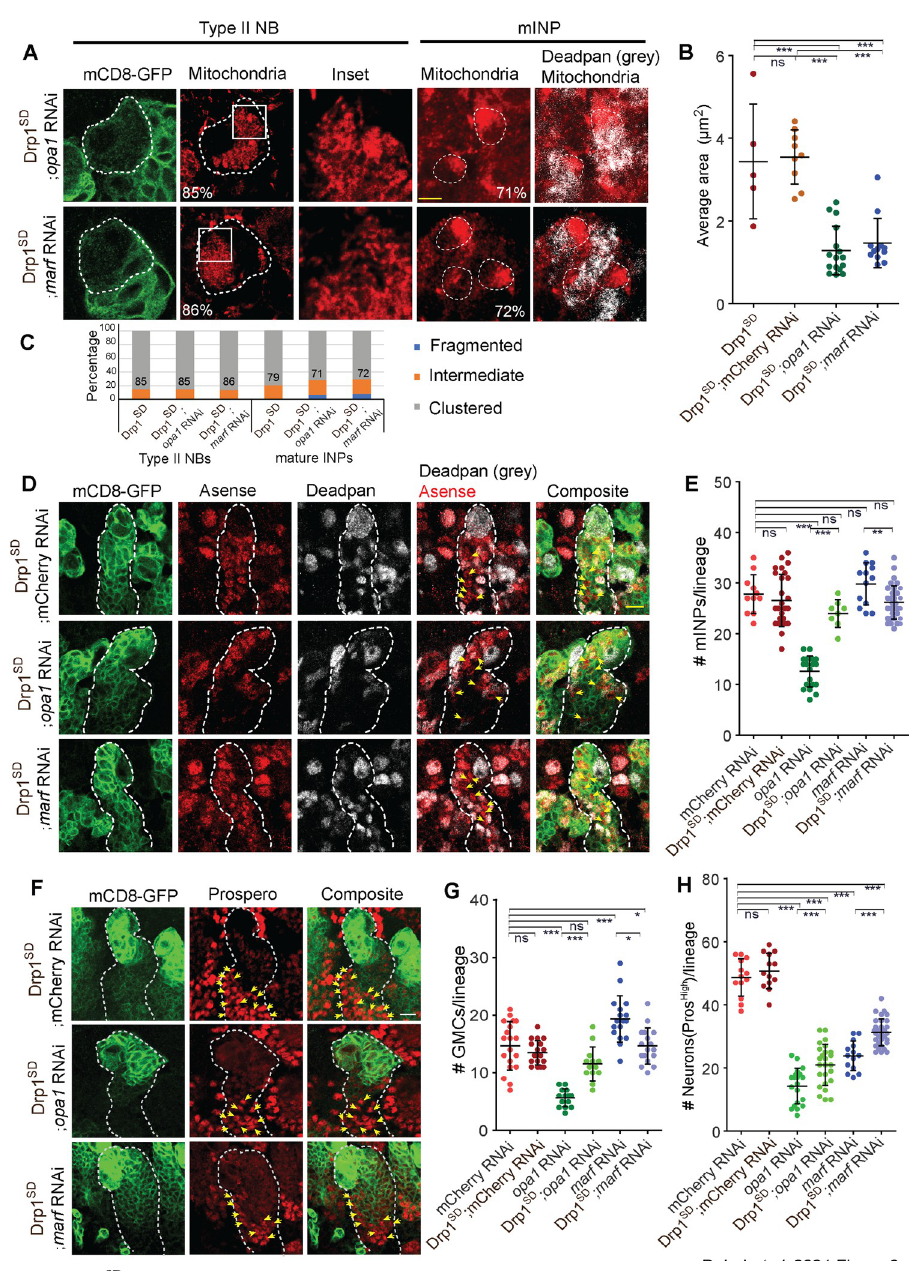
Fig 3. Drp1 SD overexpression in opa1 RNAi and marf RNAi expressing type II NB lineages suppresses the differentiation defect. A-C: Representative images with zoomed inset in the right panel of type II NBs (white dotted line) containing pnt -Gal4, mCD8-GFP (green) stained for mitochondrial morphology with ATP β (red) and imaged using STED. Mitochondria in mature INPs (Dpn+ cells, grey) are labeled using mito-GFP (red) (A). pnt -Gal4, mCD8-GFP with Drp1 SD ; opa1 RNAi (96 type II NBs,12 brains: 5% clustered; 41 mature INPs, 3 brains, 8 lineages 71% clustered), Drp1 SD ; marf RNAi (96 type II NBs,12: 86% clustered; 60 mature INPs, 4 brains, 11 lineages 72% clustered). Quantification of average mitochondrial area (B) in type II NB of mCherry RNAi (8 Type II NBs, 3 brains), Drp1 SD (5, 3), Drp1 SD ;mCherry RNAi (9,4),Drp1 SD ; opa1 RNAi (16,4), Drp1 SD ; marf RNAi (12,4). Graph shows the distribution of mitochondria into fragmented, intermediate and clustered in the form of a stacked histogram (C). The percentage documented on each bar in the histogram is for the group that is seen at the maximum extent. The values for Drp1 SD are repeated from Fig 1 for comparison. Scale bar- 5 μ m for the type II NB, 2.7 μ m for the mature INPs. D,E,G: Type II NB lineages (yellow dotted line) showing expression of mCD8-GFP (green) Ase (red) and Dpn (grey) (D). Quantification of Dpn positive mature INPs (E) in mCherry RNAi (13 NB lineages,4 brains), Drp1 SD ;mCherry RNAi (27,10), opa1 RNAi (20,8), Drp1 SD ; opa1 RNAi (8,6), marf RNAi (13,8), Drp1 SD ; marf RNAi (35,8). Quantification of